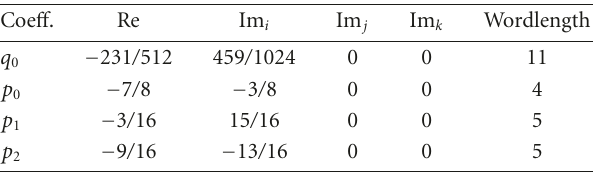
Table 2: Rational coe ffi cient values for LP PUFB. Coe ff .